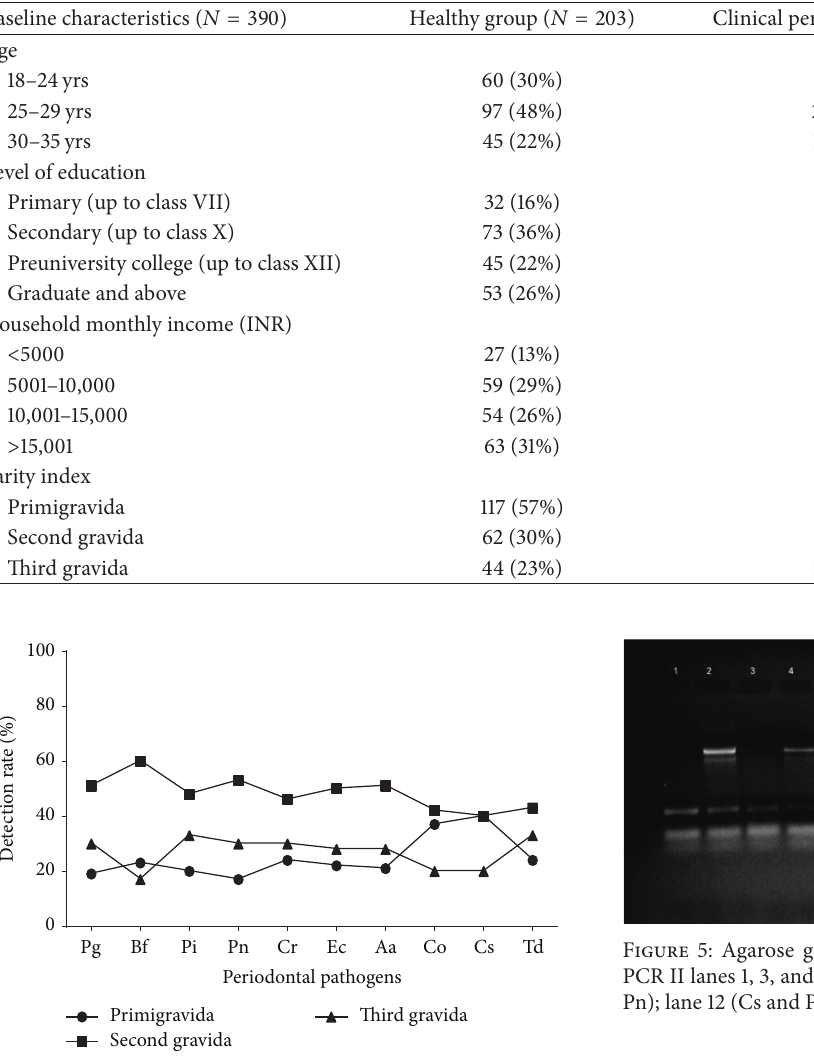
Figure 4: Detection rate of periodontal pathogens among women with varying parity.